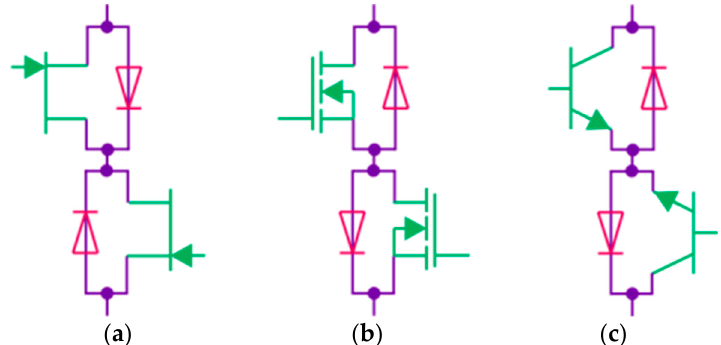
Figure 9. Main topologies for SiC bi-directional switches: ( a ) common drain anti-paralleled JFET, ( b ) common source anti-paralleled SiC MOSFET, and ( c ) common emitter anti-paralleled SiC BJT.